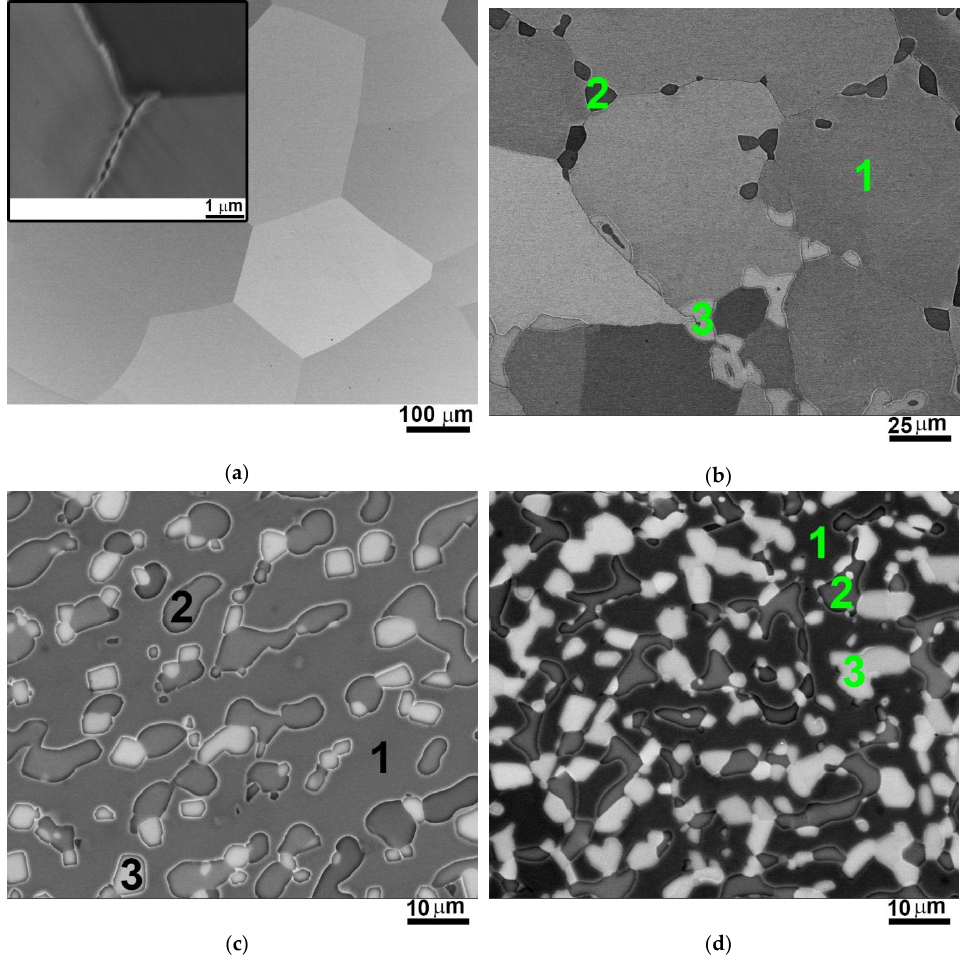
Figure 2. SEM-BSE images of the microstructures of the Al x NbTiVZr ( x = 0 ( a ); 0.5 ( b ); 1 ( c ); 1.5 ( d )) alloys after annealing at 1200 °C for 24 h. Chemical compositions and volume fractions of the numbered constituents are given in Table 1. Table 1. Chemical compositions, volume fractions and dimensions of the constituents of the Al x NbTiVZr ( x = 0; 0.5; 1; 1.5) alloys after annealing at 1200 ◦ C for 24 h. Typical regions used for analysis are shown in Figure